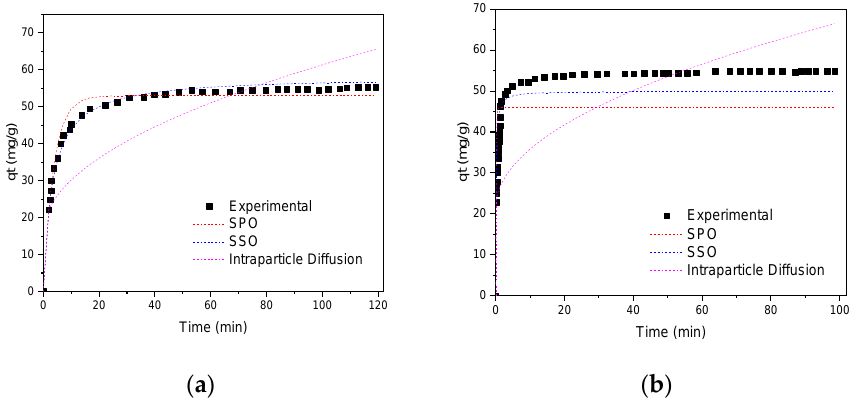
Figure 12. Adsorption kinetics on GO. Experimental conditions: Co = 25 mg L −1 , pH = 5.5, T = 298 K, CGO = 1.0 mg mL −1 : ( a ) Pb (II) on GO ( b ) Zn (II) on GO. SPO: pseudo-primer order; SSO: pseudo-second Order.